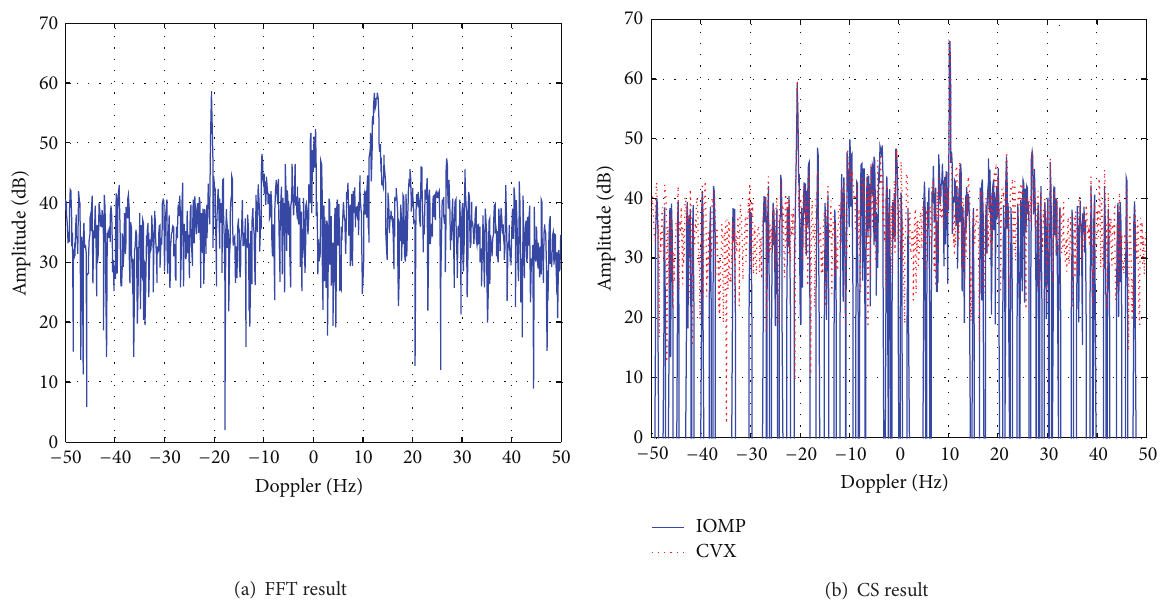
Figure 5: CS reconstruction of stably and maneuvering